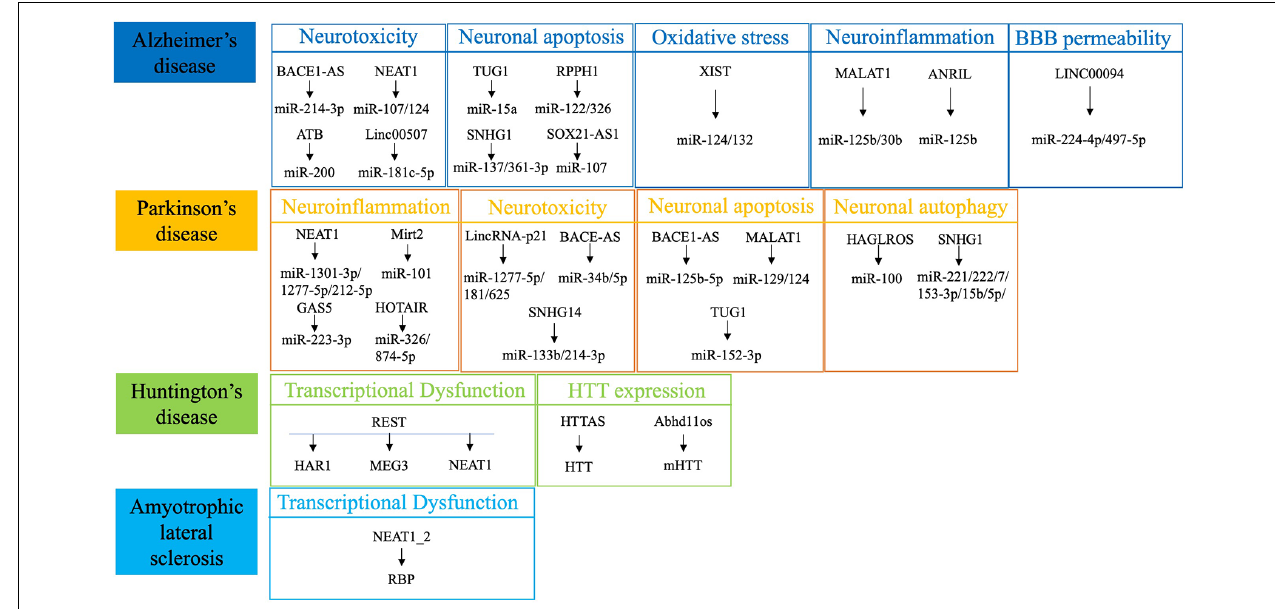
FIGURE 1 | Summary of the most dysregulated lncRNAs in neurodegenerative diseases. REST, RE1-silencing transcription factor; HTT, Huntingtin; RBP, RNA-binding